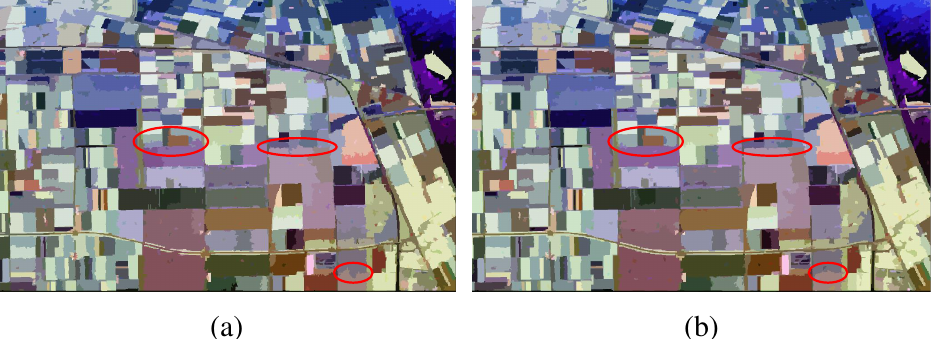
Figure 10. The segmentation results of the Flevoland image when Q is set to 250: ( a ) the